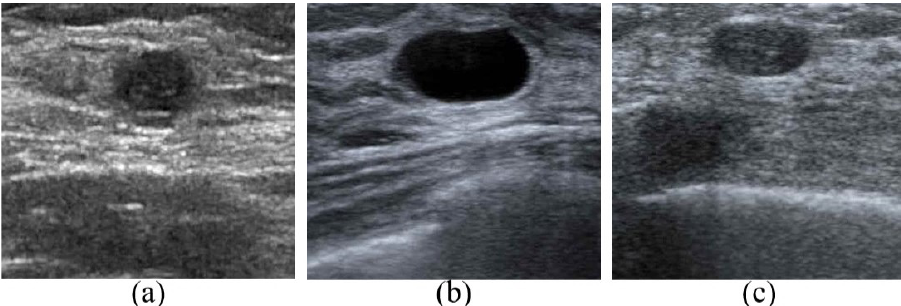
Figure 3. Different types of ultrasound imaging modalities; images compressed to the same size: ( a ) with Model B; ( b ) with Model B; ( c ) with Model C.